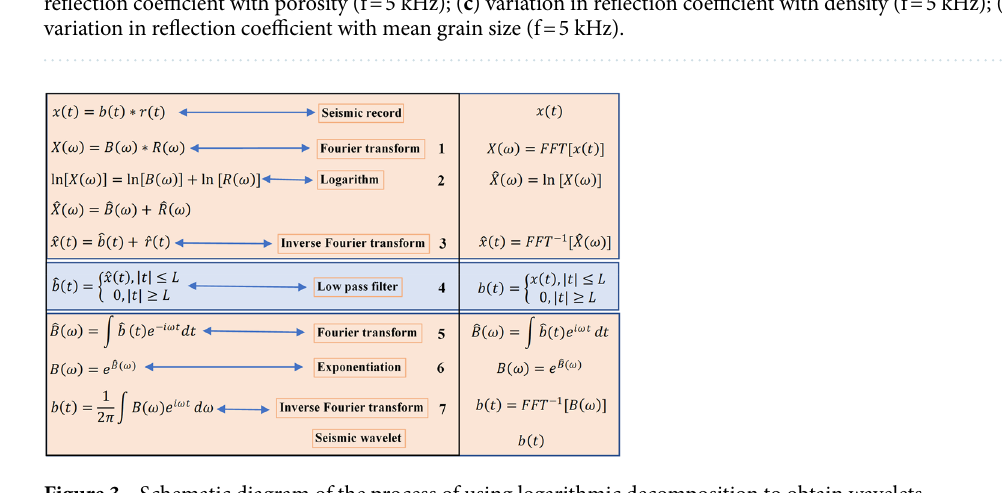
Figure 3. Schematic diagram of the process of using logarithmic decomposition to obtain